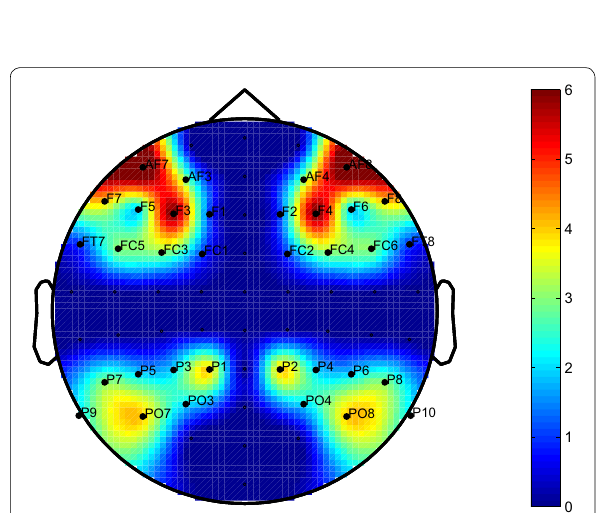
Fig. 7 Commonality index: degree of commonality of each electrode for dominant features. The degree of use was color coded, according to the color bar on the right (as the spectral differences were derived from symmetric pairs, the symmetric patterns were